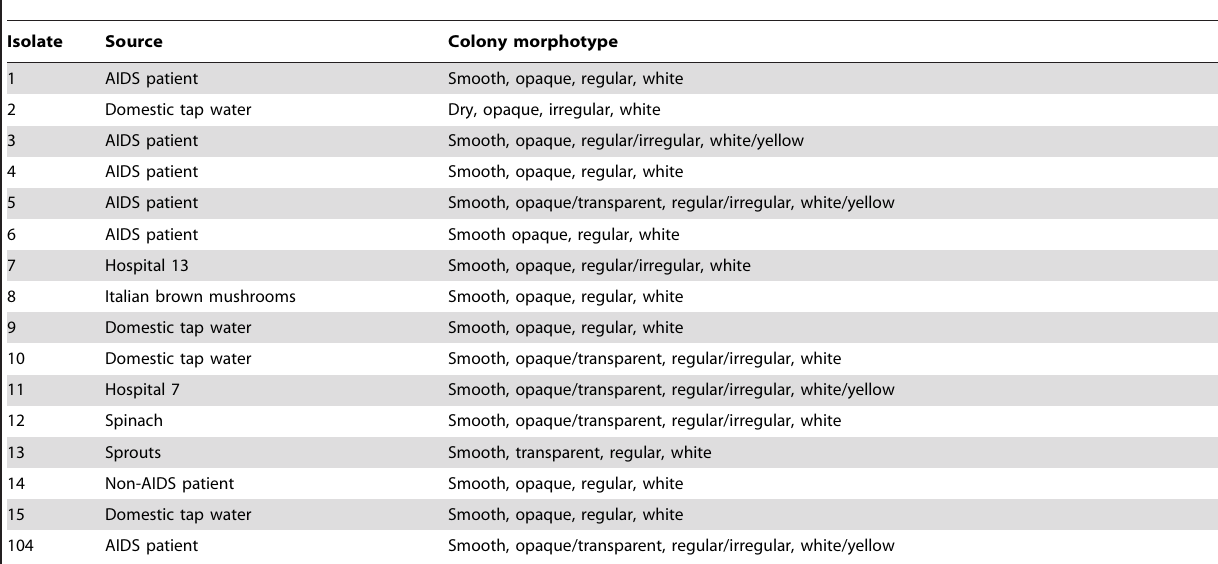
Table 1. Source and colony morphotype classification of MAC